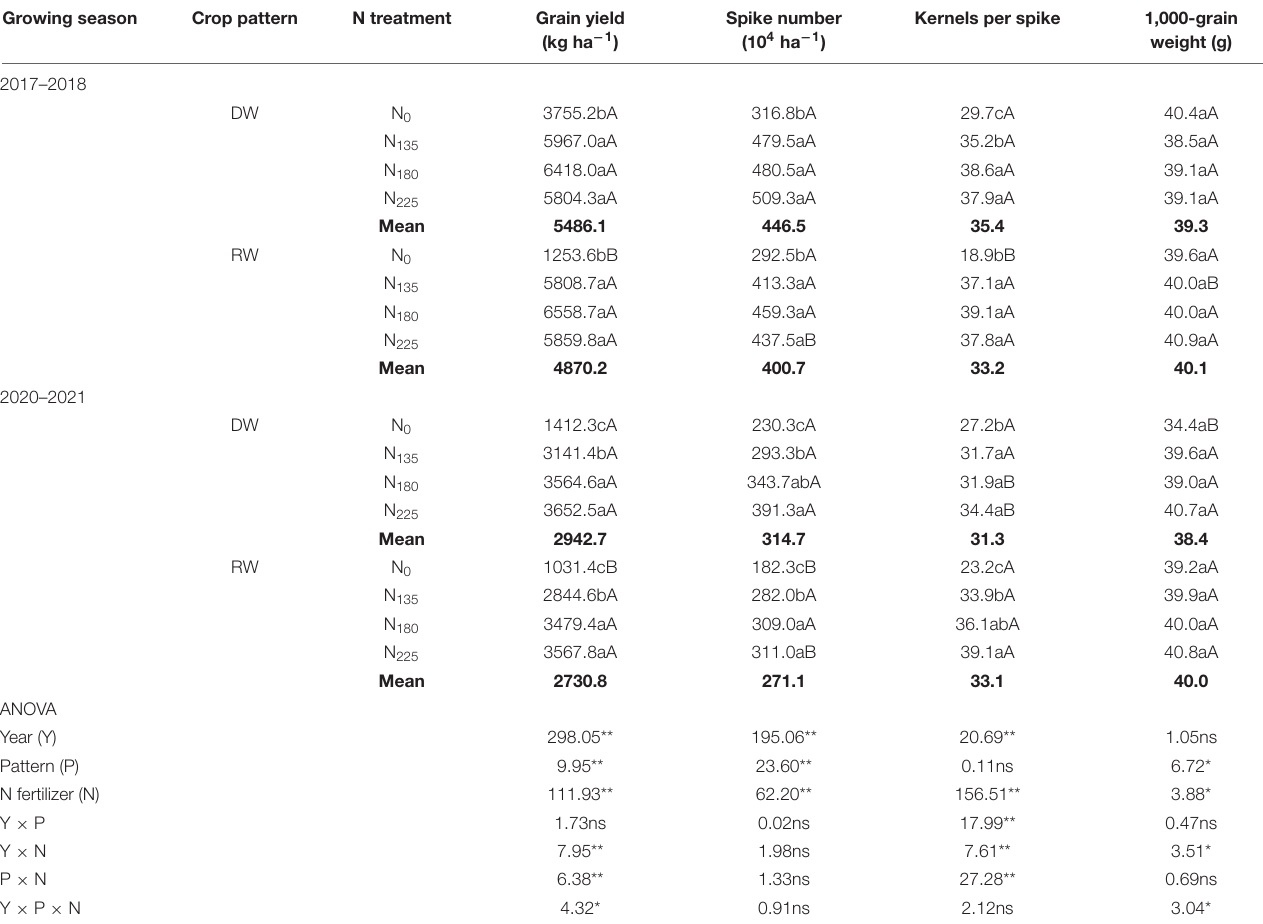
TABLE 1 | Wheat yield and yield composition at dryland wheat (DW) and rice stubble wheat (RW). Growing season Crop